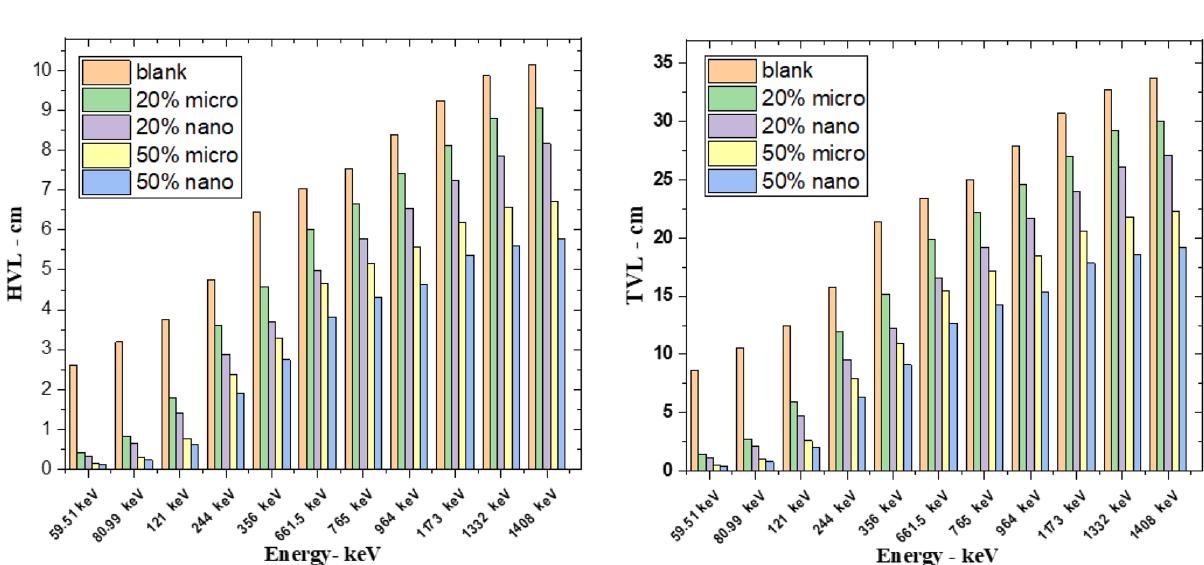
Figure 9. HVL and TVL of free silicon rubber, micro, and nano SnO 2 at different energy between data explained in El-Khatib et al. 34 where silicon rubber reinforced with nano lead at 20 and 50% weight fraction. Comparison described that LAC of 20% lead was higher than 20%tin in all energy except 59.51 and 80.99 keV only which explained by k-edge of lead in this range of energy. At 50% lead has higher LAC than 50% tin in all energy where densities of lead composites were higher than tin composites in all weight fraction.